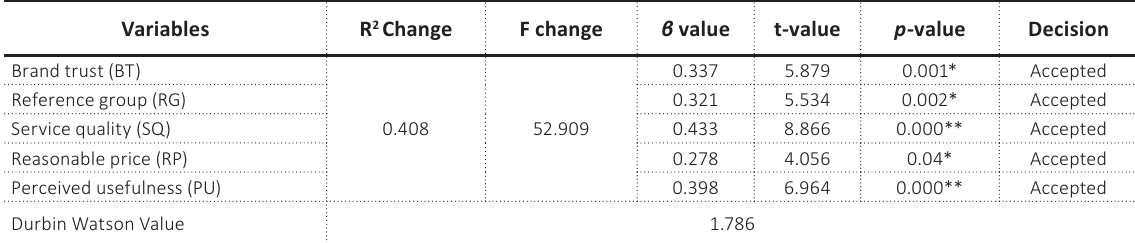
Table 2. Regression analysis